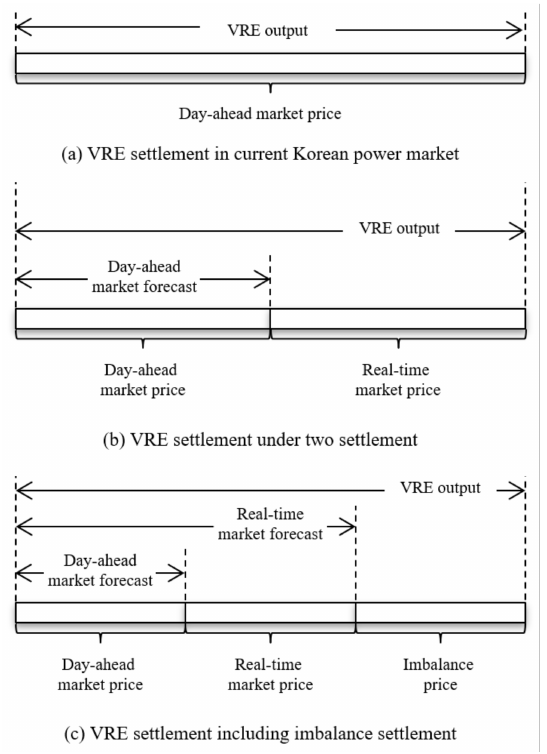
Figure 1. Settlement of variable renewable energy (VRE) ( a ) under current Korean power market rules, ( b ) under a two-settlement, ( c ) and including an imbalance